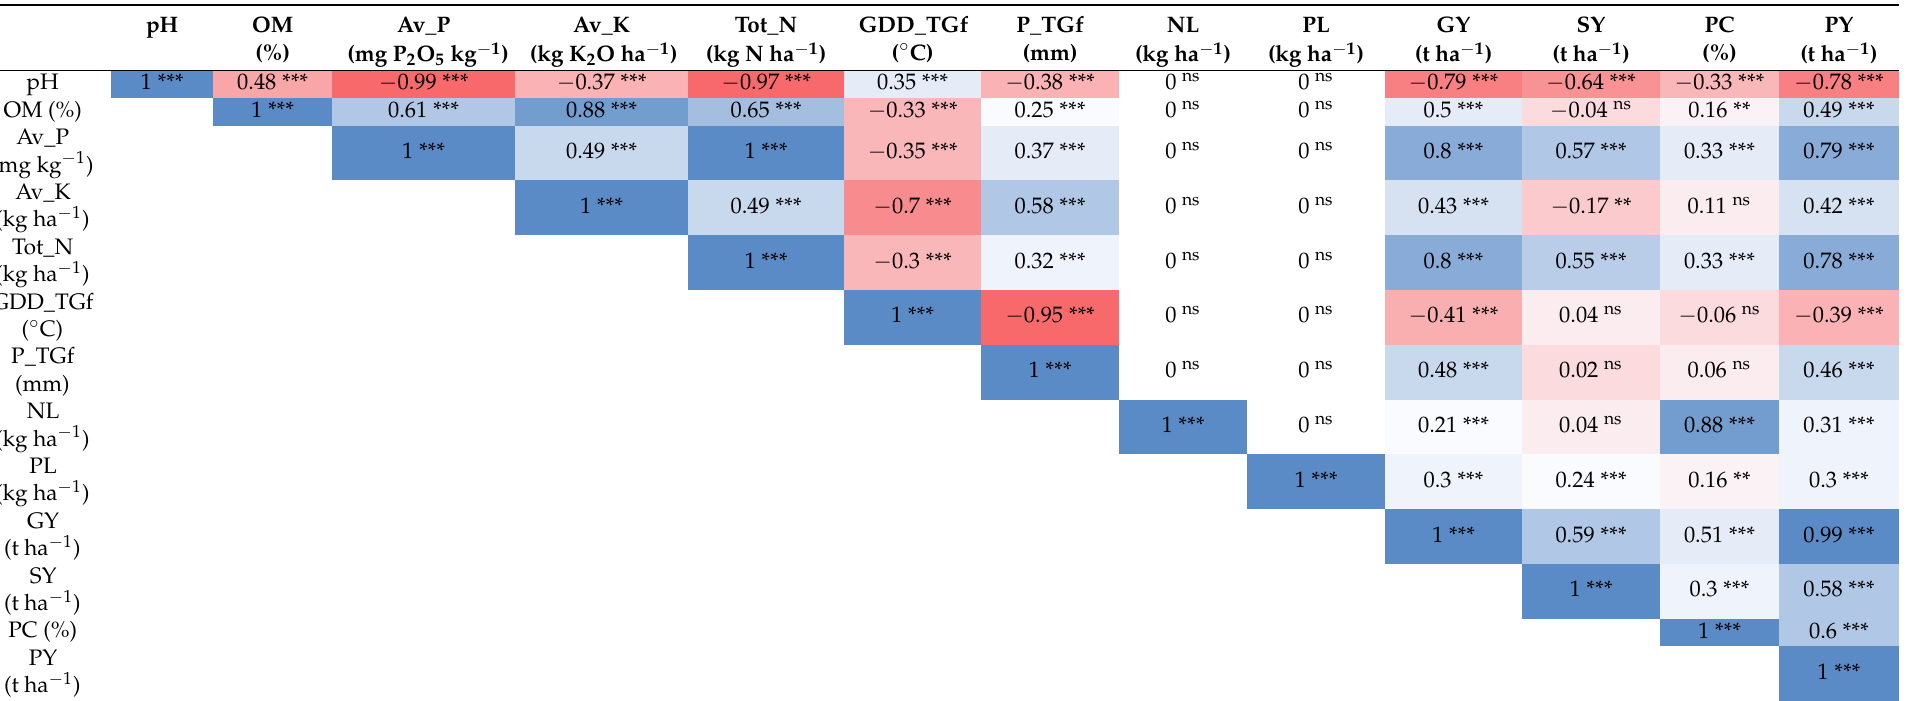
Table 4. Correlation between soil parameters (including: pH, organic matter (OM), available phosphorous (Av_P), available potassium (Av_K), total nitrogen (Tot_N), climatic parameters (including growing degree days (GDD_TGf) and precipitation amount (P_TGf ) cumulated between tillering and grain filling), and agronomic traits (including grain yield (GY), straw yield (SY), protein concentration (PC), and protein yield (PY)). The values reporting the correlation significance are as follows: *** = 0.001, ns = not